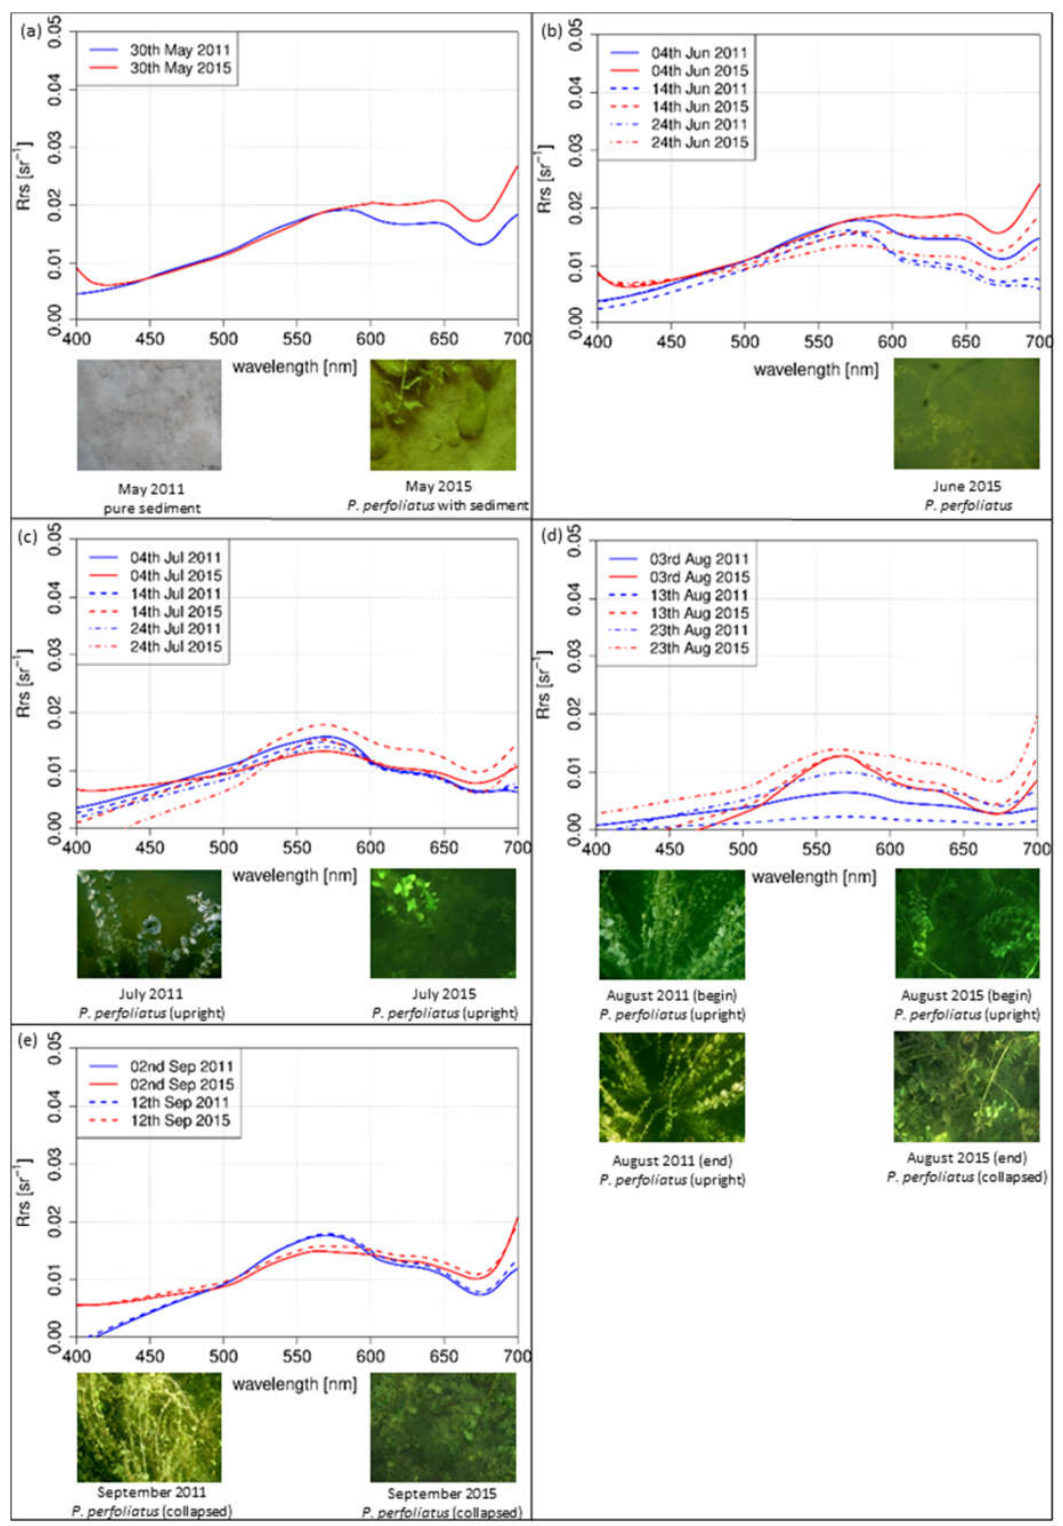
Figure 7. Simulated R rs intensities of P. perfoliatus modeled with a linear interpolation method of 2011 (blue) and 2015 (red). Top view photos of the investigated test sites of the sampling days: ( a ) May; ( b ) June; ( c ) July; ( d ) August; and ( e ) September.